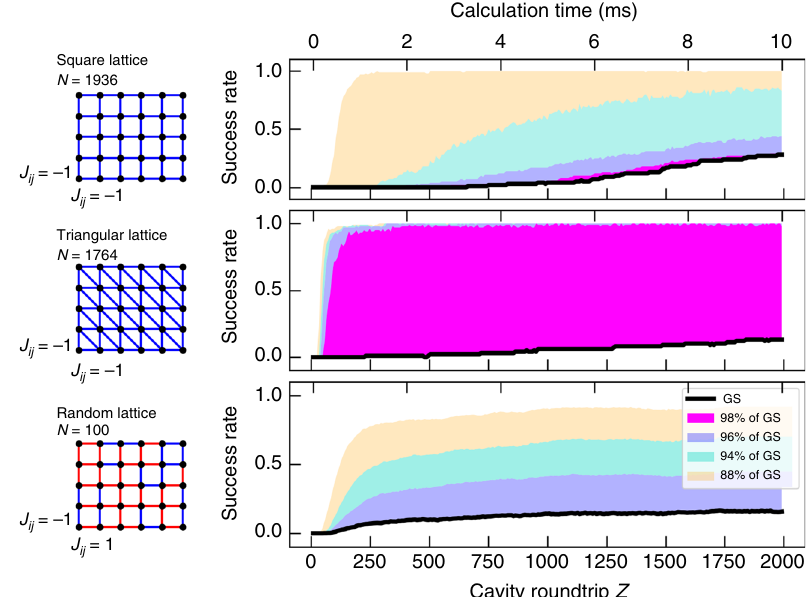
Fig. 5 Success rate to reach the ground state for various 2D graphs. Graph structure and time evolution of the success rate to reach the ground state for the regular lattice, triangular lattice and 2D random lattice. For the graph structures, red links indicate ferromagnetic coupling and blue links indicate anti- ferromagnetic coupling. The different colors for the success rate indicate the frequency of cases where 98% (magenta), 96% (blue), 94% (turquoise) and 88% (orange) of the ground state energy was